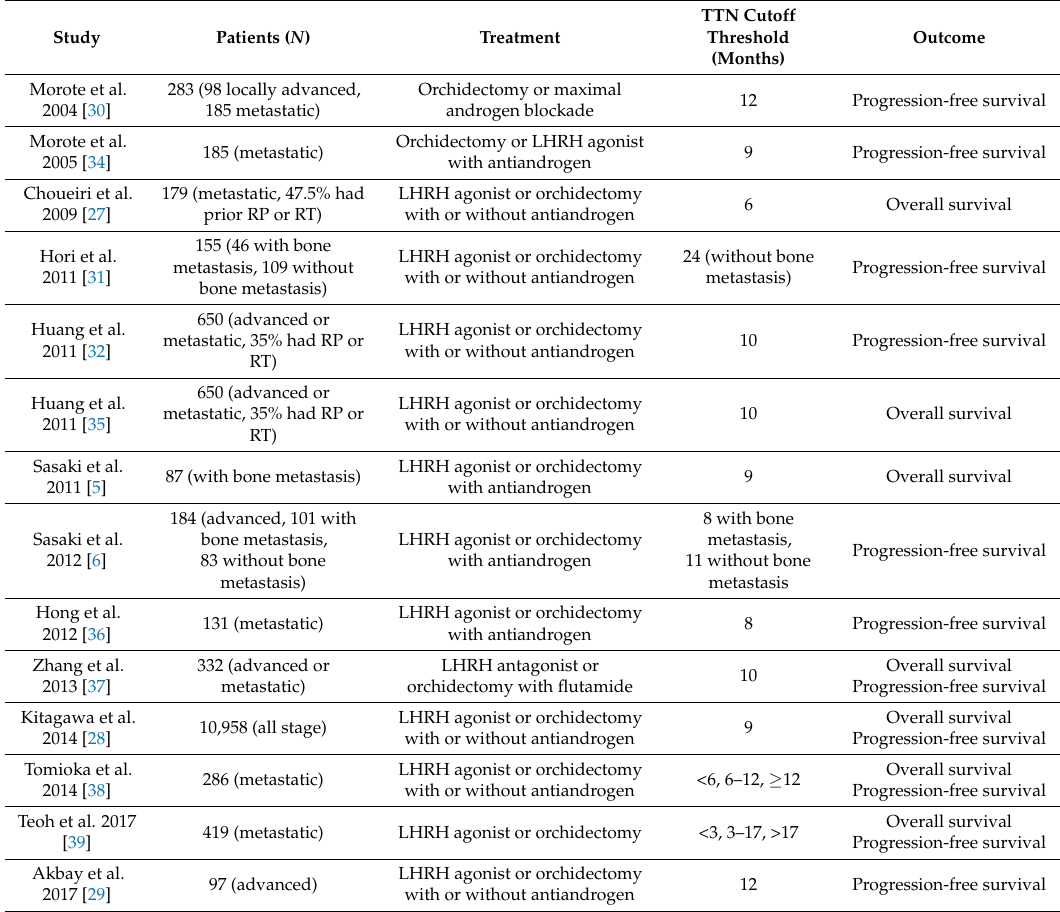
Table 1. Examination of TTN after primary ADT in hormone-naïve PCa patients as a prognostic marker for disease